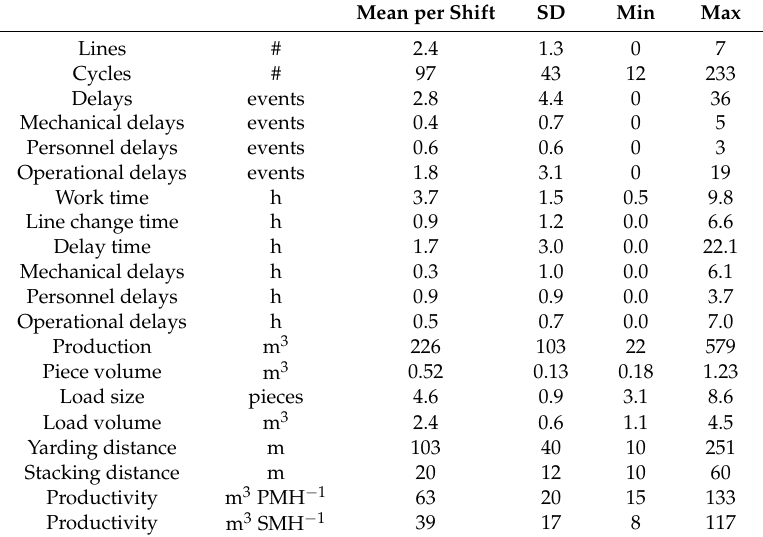
Table 2. Main results obtained from the shift level study of the grapple yarder teams.